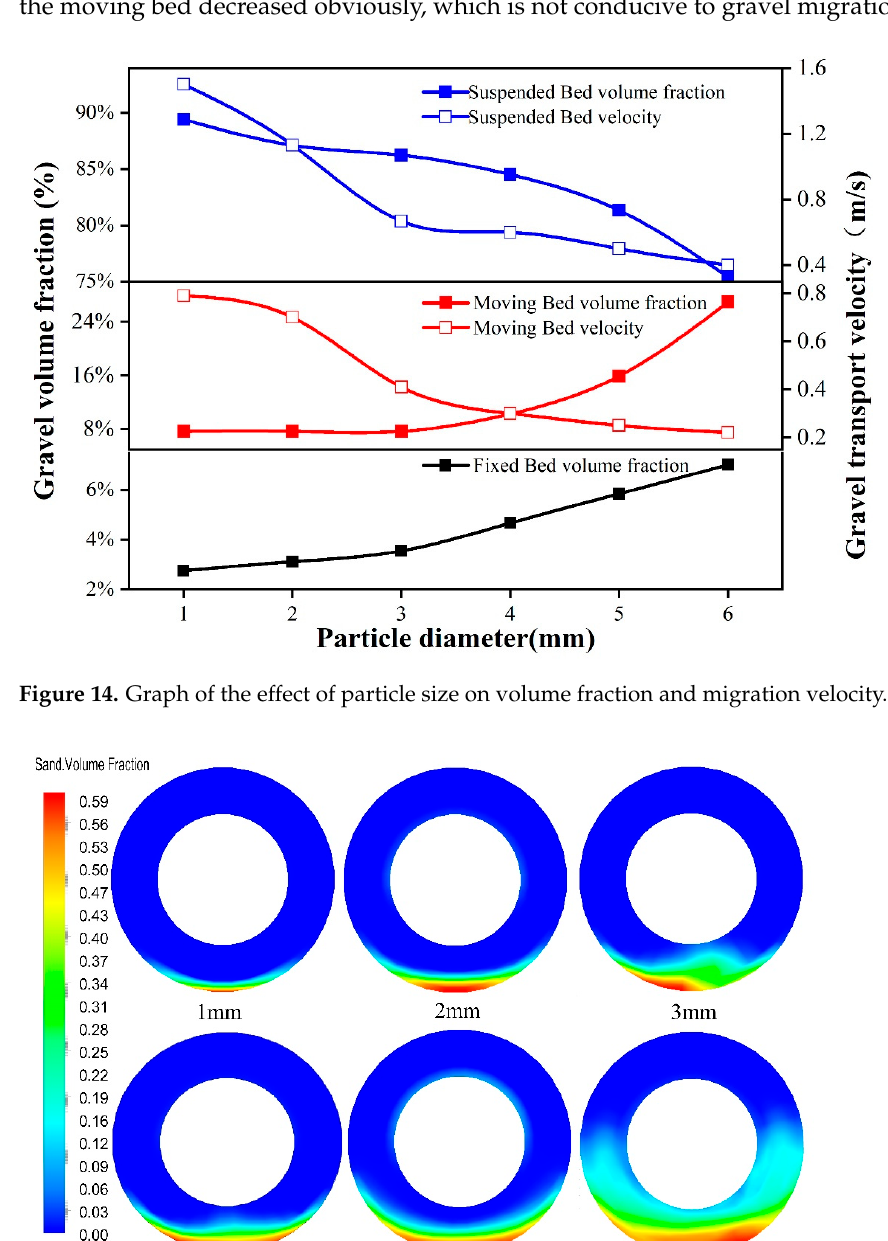
Figure 16. Graph of the effect of carrying ratio on the volume fraction and migration velocity.